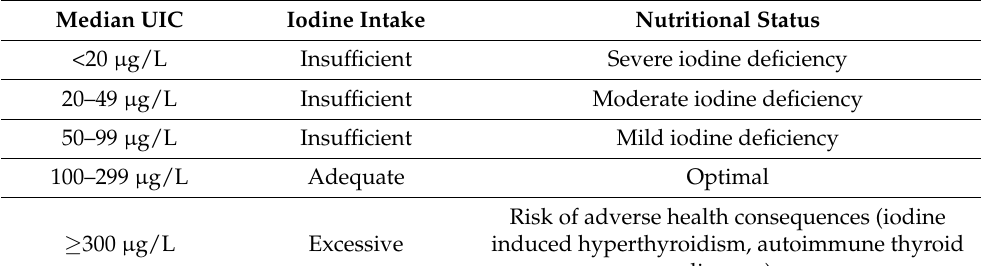
Table 1. Assessment of iodine intake in the general population based on median urinary iodine concentrations (UICs). Adapted from